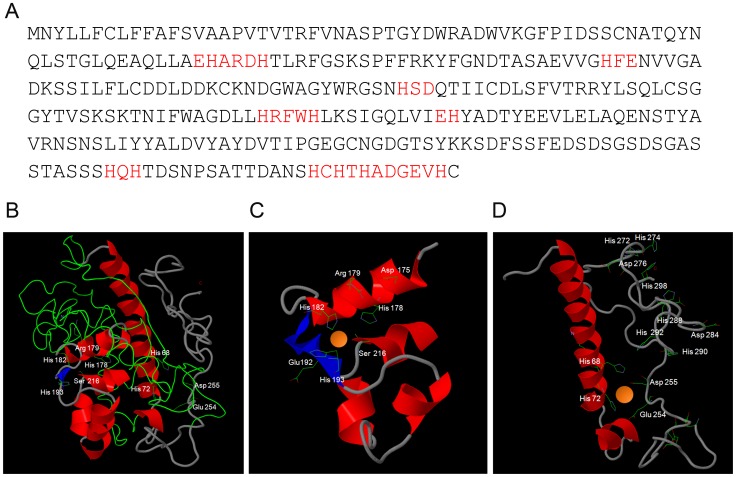

In silico prediction of Pra1-zinc binding.(A) Primary amino acid sequence of Pra1 (Candida Genome Database) with zinc-binding motifs in red. (B) Three-dimensional model of Pra1 built with Phyre2. (C) and (D) close-up of predicted zinc coordination sites. Note the presence of arginine, rather than glutamic acid at residue 179 (C) and that the C-terminal tail of Pra1 has multiple additional potential zinc binding histidine residues (D).